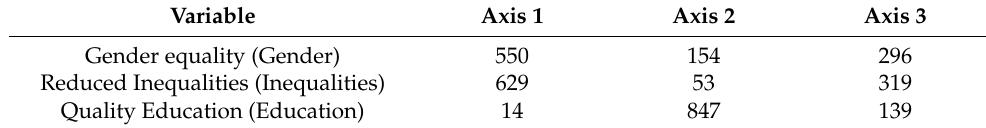
Table 6. Contribution of each factor axis to the variability of THE Impact Rankings indicators.